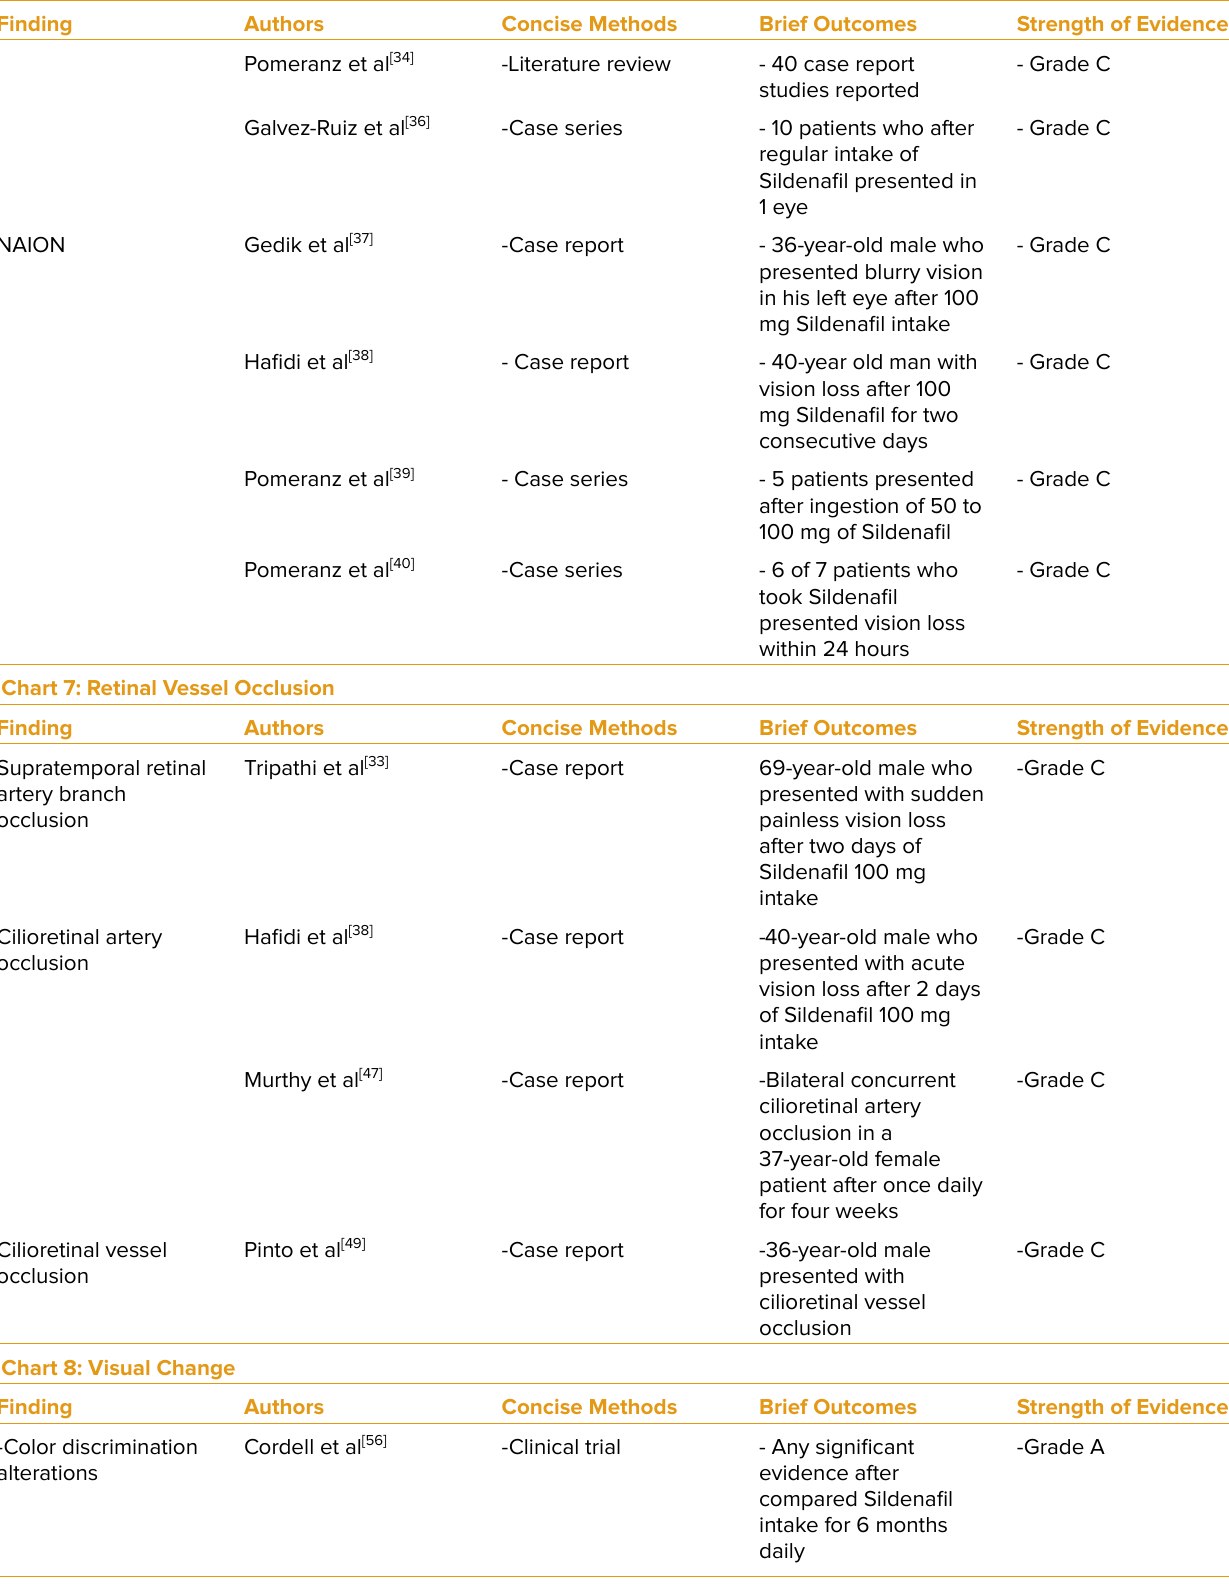
Chart 6: Non-Arteritic Ischemic Optic